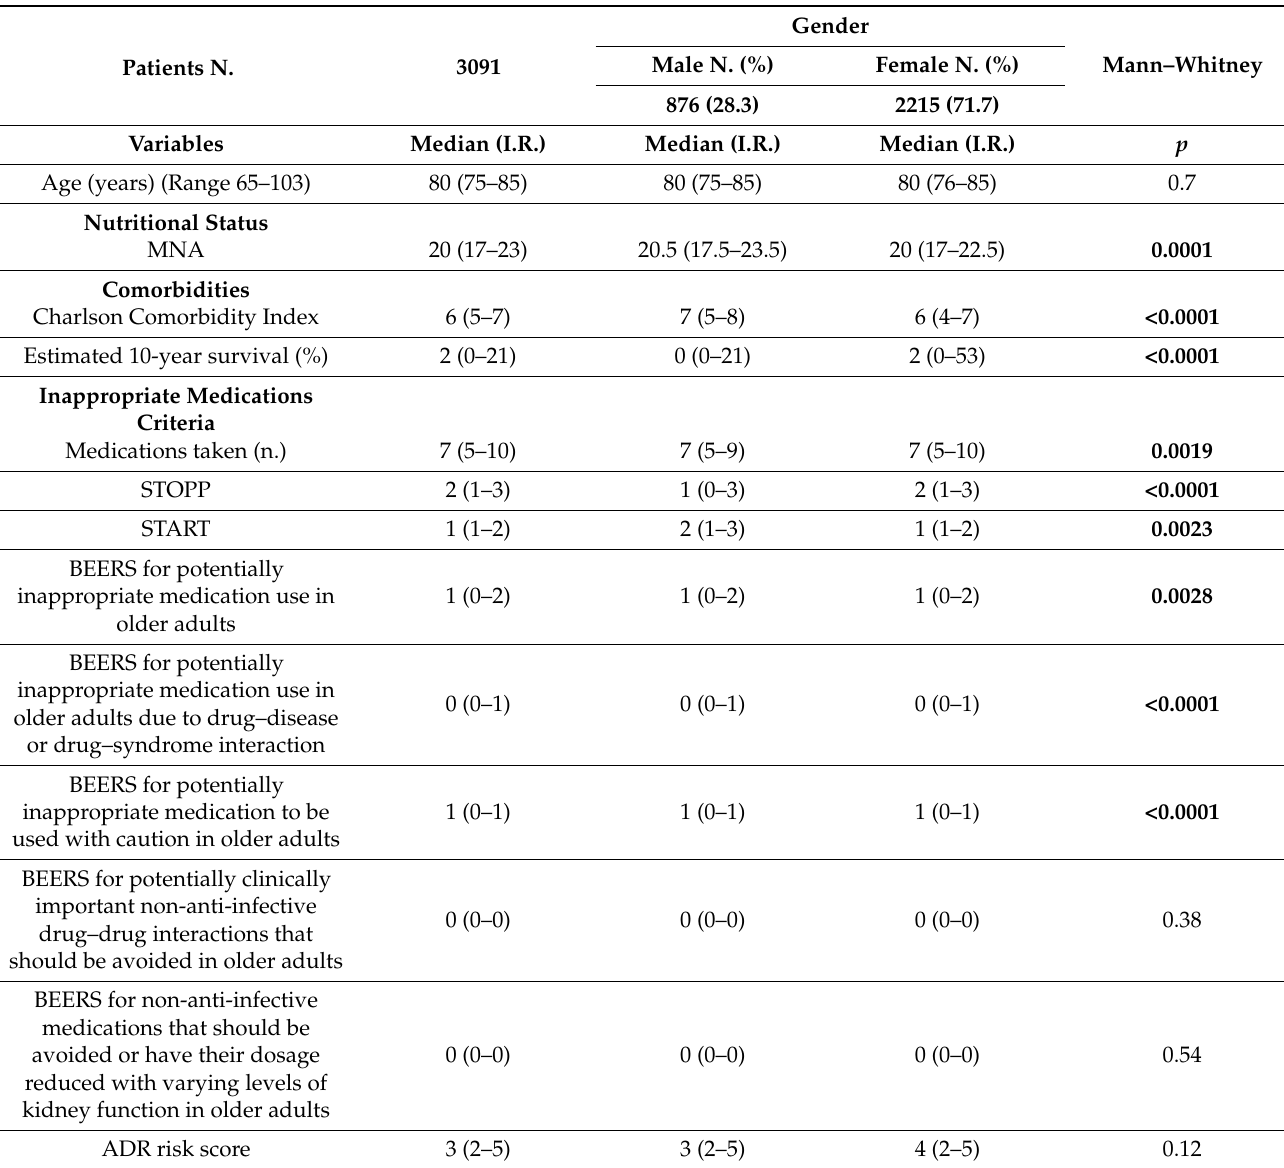
Table 1. Characteristics of the study population.